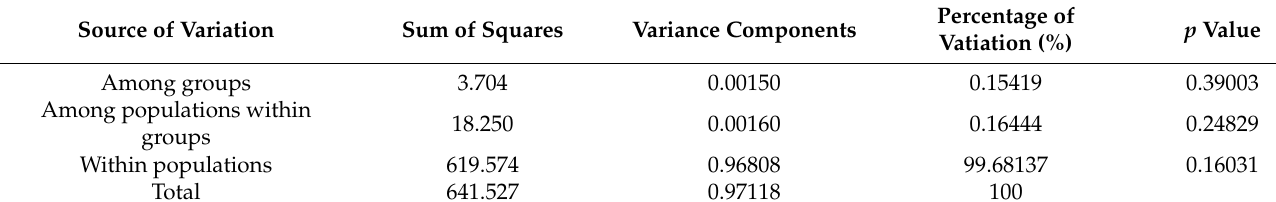
Table 3. Analysis of molecular variance (AMOVA) of mtDNA COI sequence of wild croaker in China.